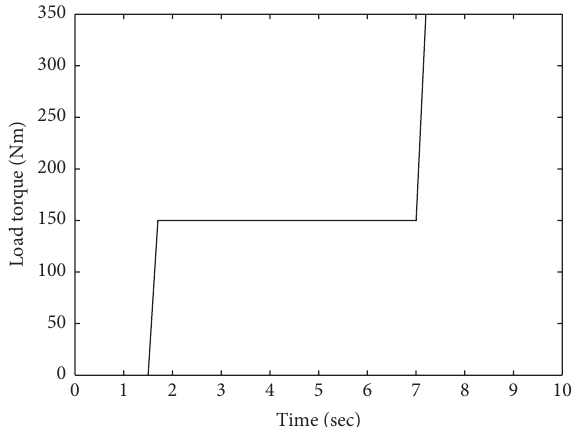
Figure 11: Time-varying profile of the load torque.